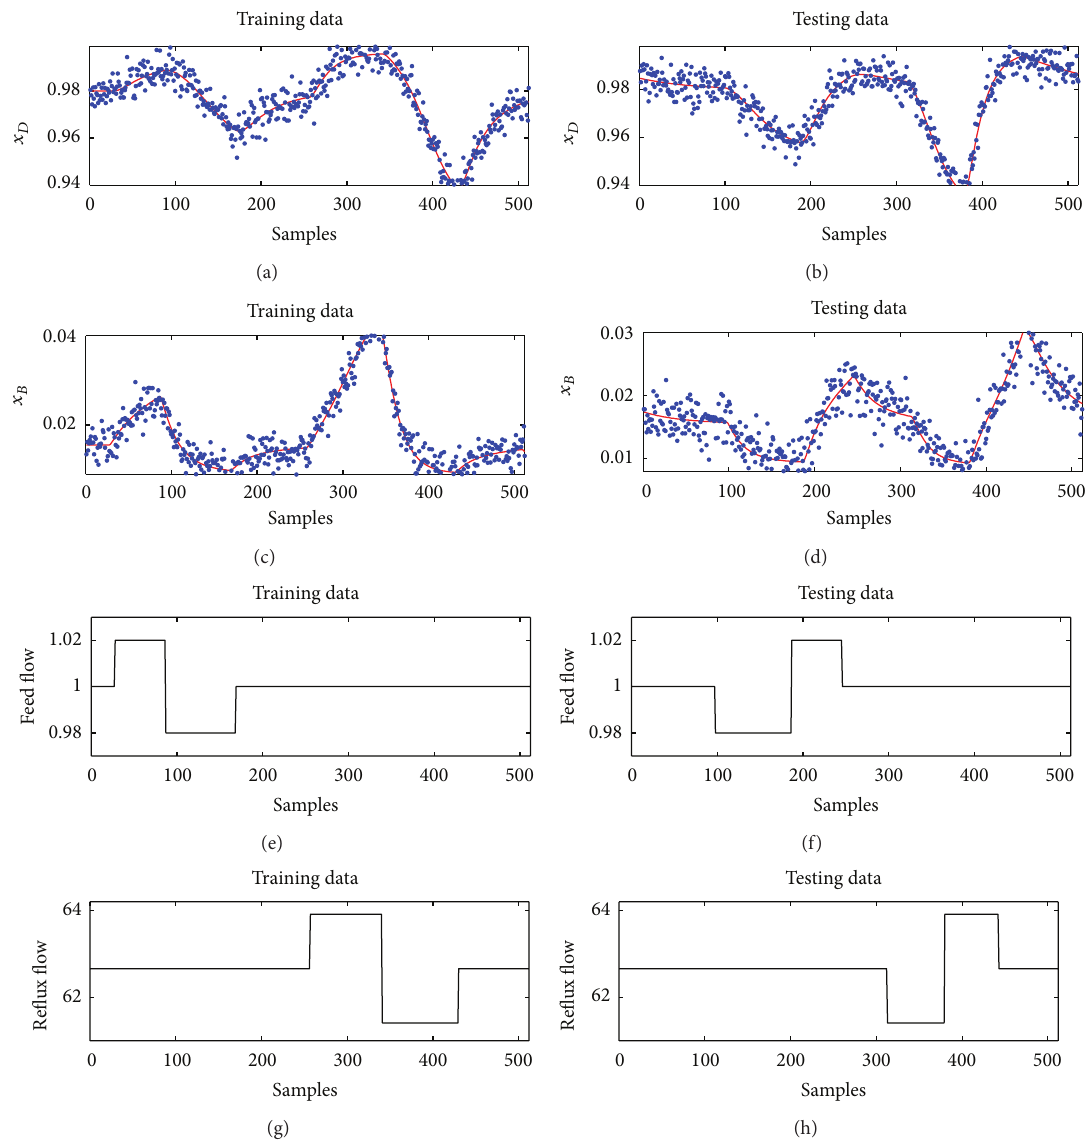
Figure 6: The dynamic input-output data used for training and testing the models in the simulated distillation column example for the case where the noise SNR = 10 (solid red line: noise-free data; blue dots: noisy